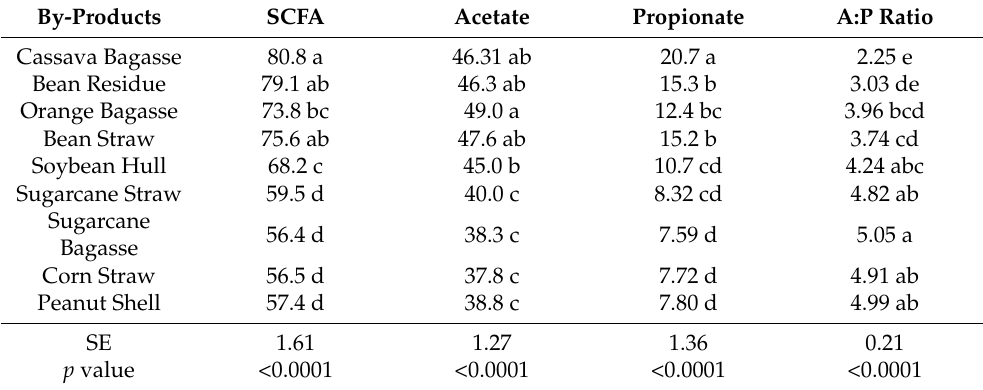
Table 3. Short-chain fatty acid concentration (mmol L − 1 ) of the by-products after a 24 h incubation period. By-Products